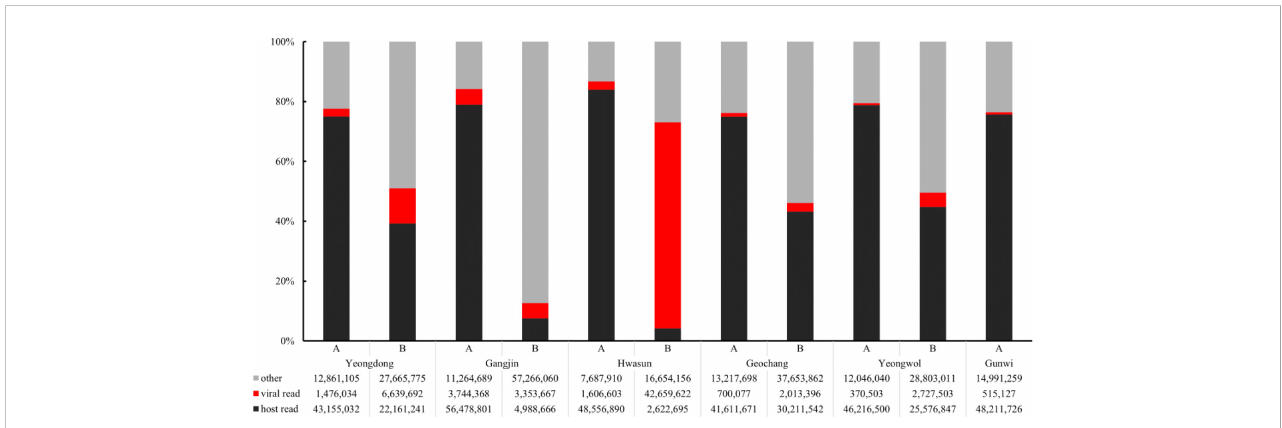
FIGURE 1 Comparison of read counts from six regions. Numbers of host reads (in black), viral reads (in red), other reads (in gray) were distinguished. Group “ A ” has fewer viral reads than Group “ B ”